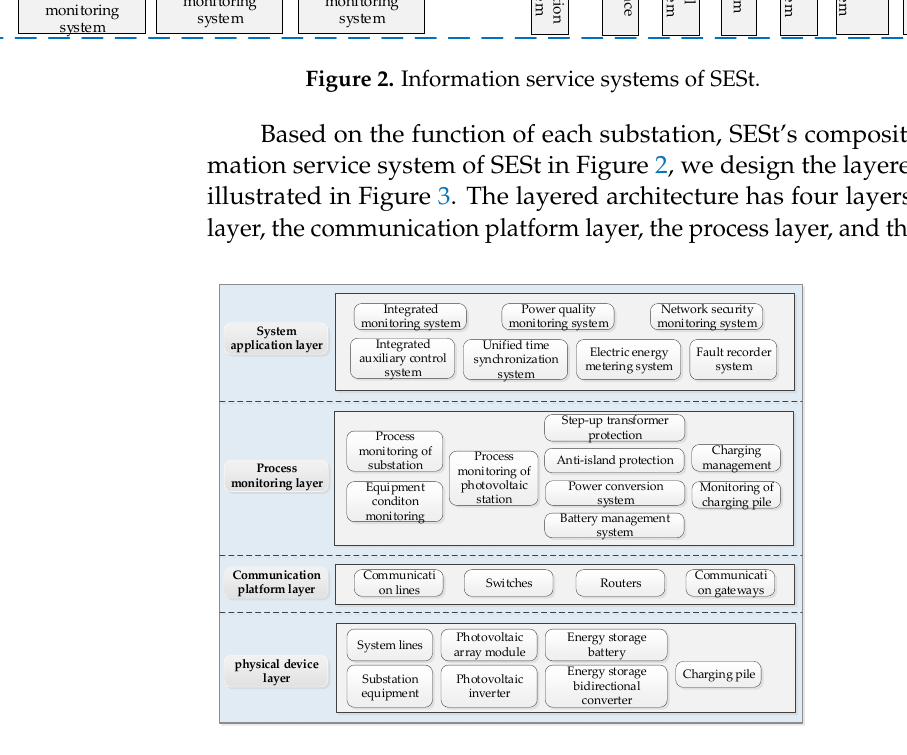
Figure 3. Layered architecture of SESt.